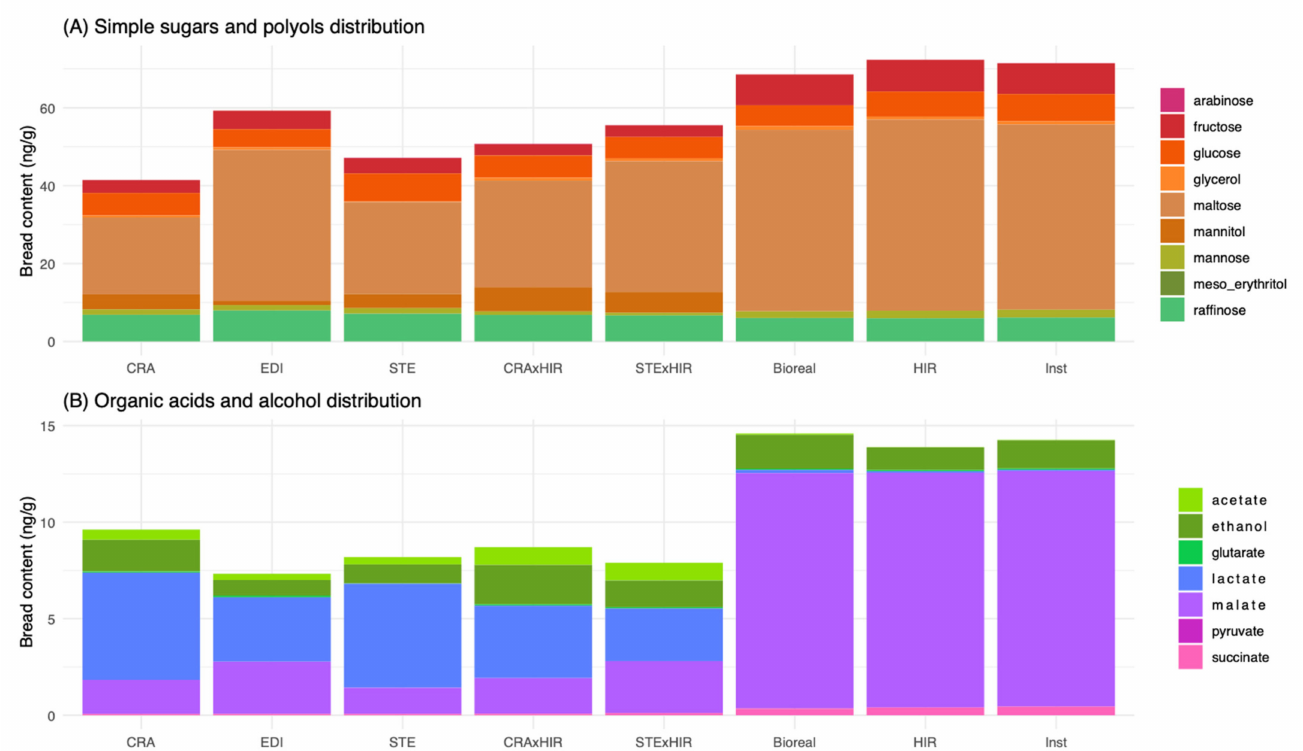
Figure 3. Distributions of ( A ) bread sugars (fructose, glucose, maltose, mannose, raffinose, arabinose, and xylose) and polyols (mannitol, glycerol, and meso-erythritol) contents (g per kg of bread) according to the leavening agent and ( B ) bread organic acids (acetate, glutarate, lactate, malate, pyruvate, and succinate) and ethanol contents (g per kg of bread) according to the 8 leavening agents (sourdoughs CRA, EDI, and STE, mixed sourdough/yeast CRA*HIR and STE*HIR, and commercial yeasts Bioreal, HIR, and Inst). (“CRA”, “EDI”, and “STE” refer, respectively, to the bakers Collectif Cravirolla, Edith Brissiaud, and St é phane, and “HIR”, “Bioreal”, and “Inst” refer, respectively, to